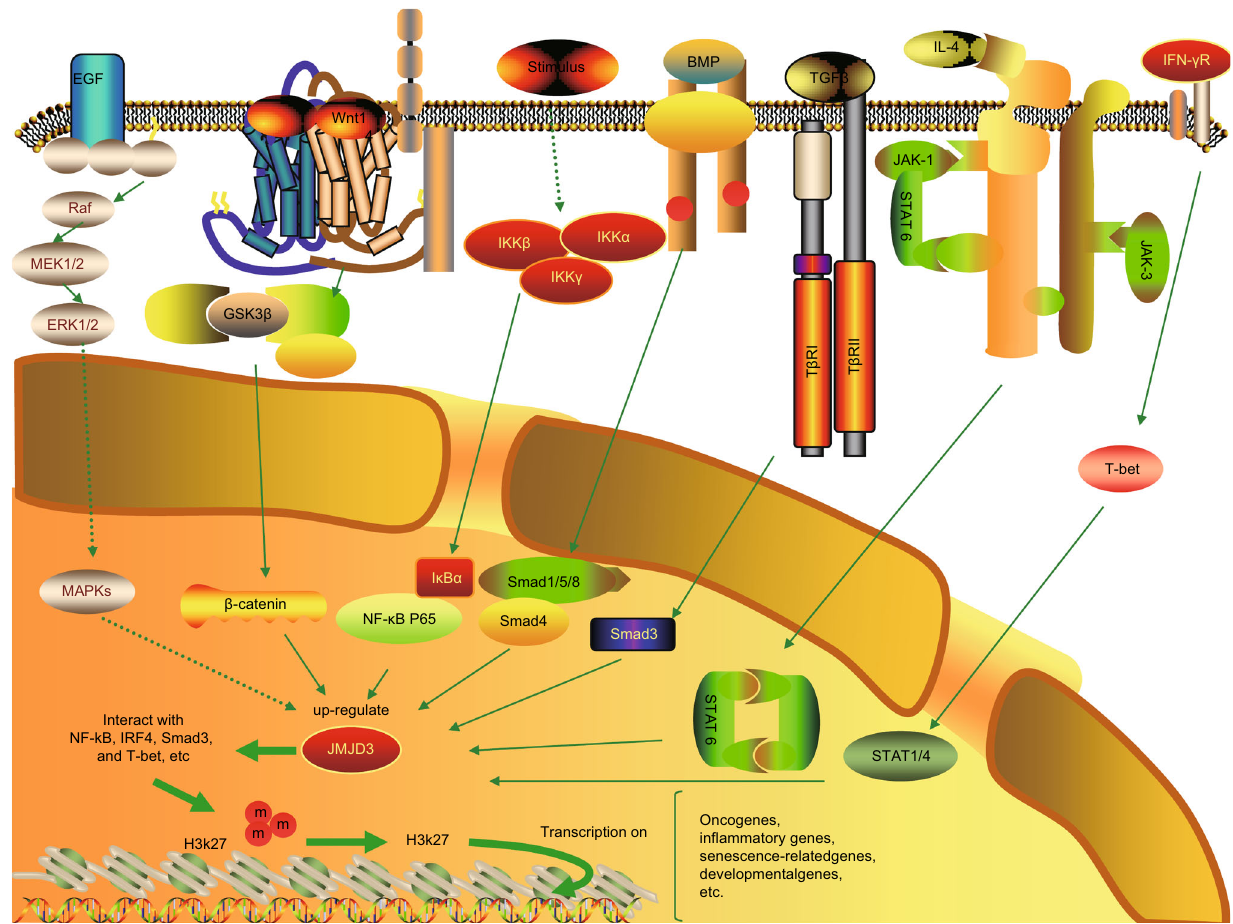
Figure 1. A schematic fi gure describing the regulatory network associated with JMJD3. JMJD3 can be upregulated via distinct signalling pathways, i.e., MAPK signaling, Wnt signalling, NF- κ B signaling, BMP signalling, TGF- β signalling, IL-4-STAT6 signaling, and T-bet signaling. Then JMJD3 is recruited to the chromatin via interacting with several transcription factors. JMJD3 activates the transcription of oncogenes, in fl ammatory genes, developmental genes by demethylating the repressive H3K27me3 markers on their promoters and gene bodies. The induction of JMJD3 modi fi es the responses during the occurrence and development of various kinds of human